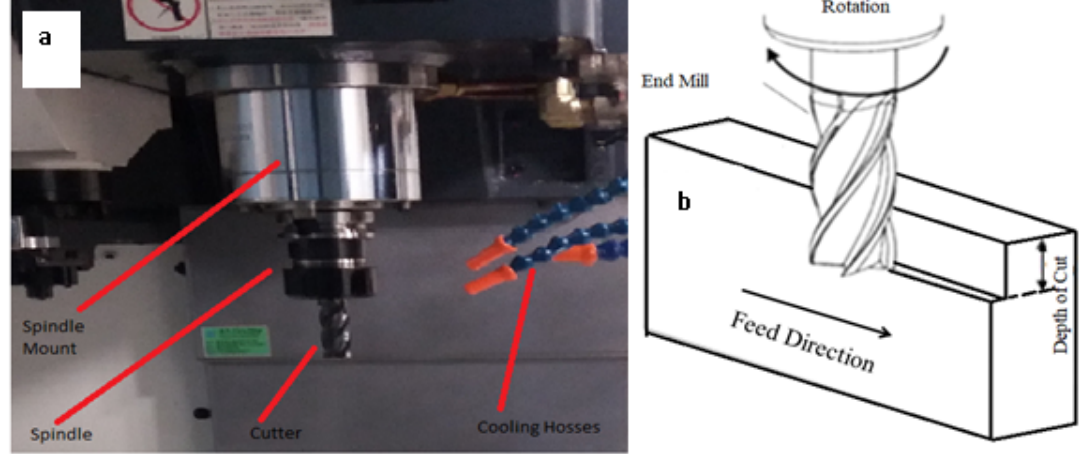
Figure 4. ( a ) Assembly of end mill cutter and ( b ) engagement and basic tool motion on workpiece.